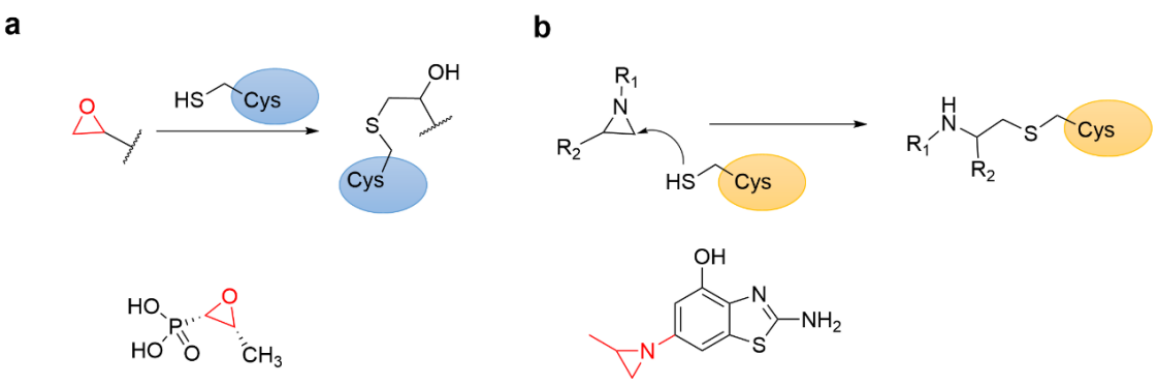
Figure 14. ( a ) The mechanism of covalent adduct formation between epoxides and cysteine and the chemical structure of fosfomycin. ( b ) The mechanism of aziridine forming a covalent adduct with cysteine and the chemical structure of aziridine-based irreversible covalent NSD1 inhibitor. Aziridine has also been developed as a cysteine-targeting warhead. The moiety has been studied and applied as mechanism-based inhibitor of glycosidase and cysteine pro- tease (Figure 14b). Recently, Cierpicki et al. developed an irreversible covalent inhibitor with an aziridine moiety against nuclear receptor-binding SET domain protein 1